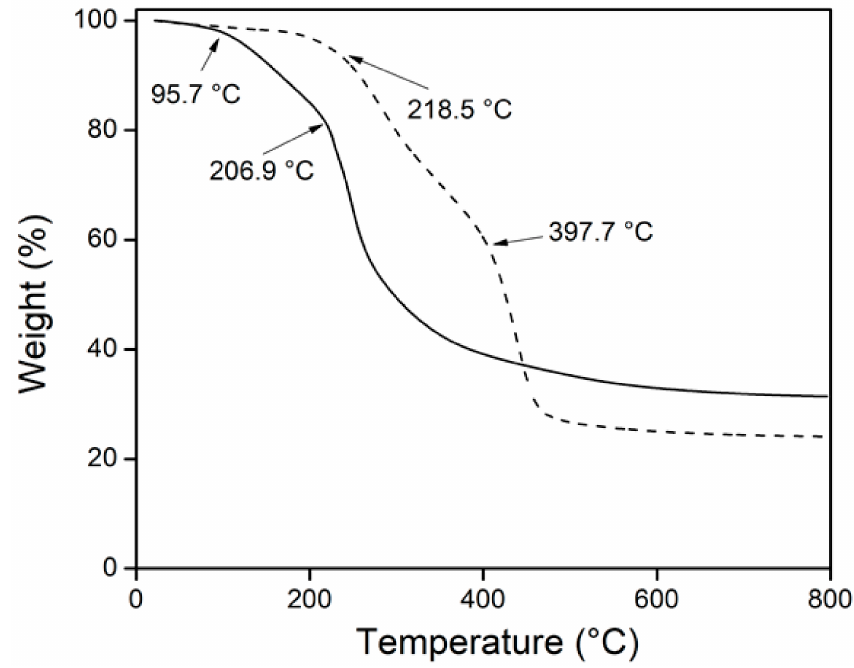
Figure 8. TGA results for net -CS (—) and ( net -CS)- g -NVCL/AAc (32 %) (–